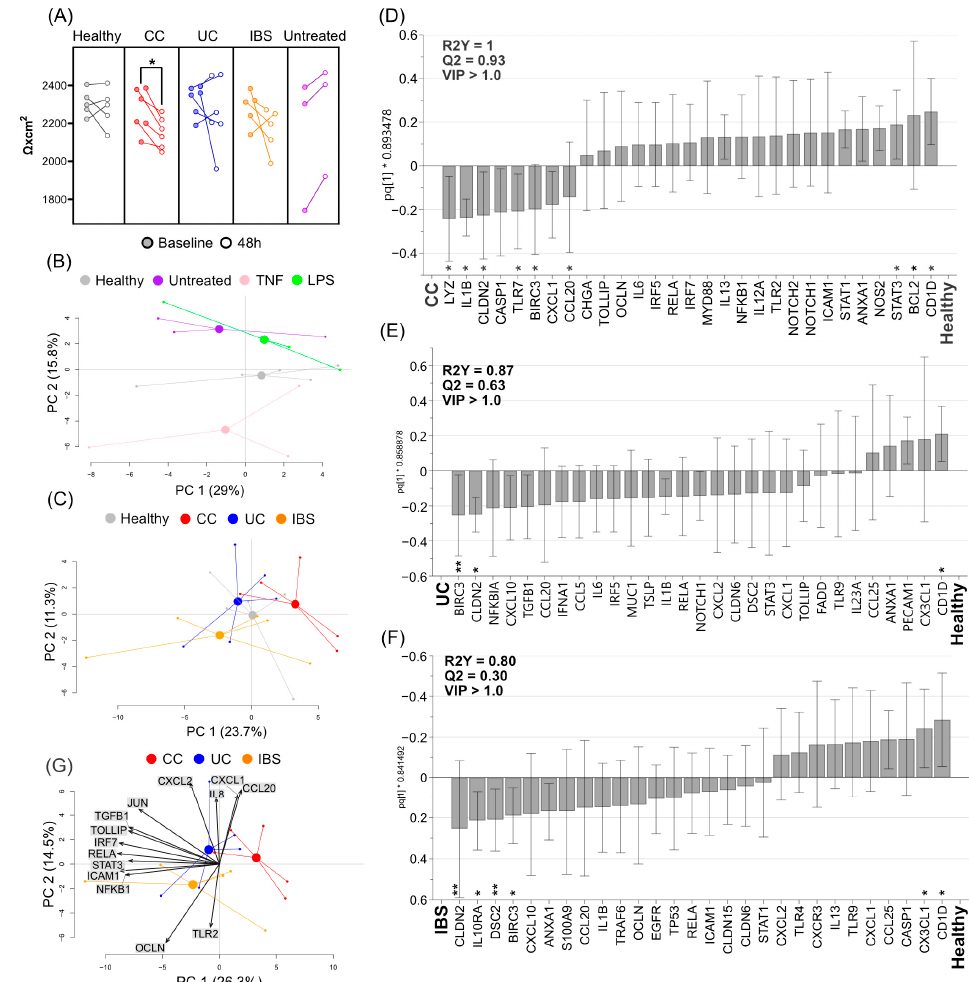
Figure 2. Gene expression of Caco-2 monolayers stimulated with fecal supernatants from healthy subjects and patients with colon cancer (CC), ulcerative colitis (UC) and irritable bowel syndrome (IBS). Caco-2 monolayers were differentiated for 20 days and stimulated apically with fecal super- natants and LPS or basolaterally with TNF or left untreated (cell culture medium alone), for 48 h. ( A ) Transepithelial electrical resistance was measured before (filled dots, each dot representing one sample) and after stimulation (corresponding unfilled dot), for healthy (grey), CC (red), UC (blue) and IBS (orange). Gene expression was analyzed by a custom PCR array. ( B ) Principal component analysis (PCA) for cells treated with fecal supernatants from healthy subjects (grey), LPS (green), TNF (pink) and media (purple). ( C ) PCA for cells treated with fecal supernatants from healthy subjects and CC (red), UC (blue) and IBS (orange) patients. Column loading plots from orthogonal partial least squares discriminant analyses (OPLS-DA) using a VIP cut-off > 1.0, comparing ( D ) healthy subjects and patients with CC, ( E ) healthy subjects and patients with UC and ( F ) healthy subjects and patients with IBS. ( G ) A PCA biplot for cells treated with fecal supernatants from patients with CC, UC and IBS. Between-group comparisons were tested with Mann–Whitney U test; asterisks identify statistically significant p values: * p < 0.05; ** p < 0.01. LPS ( n = 3), TNF ( n = 3), media ( n = 3); fecal supernatants ( n = 5 for each group). CC, colon cancer; UC, ulcerative colitis; IBS, irritable bowel syndrome; TNF, tumor necrosis factor; LPS, lipopolysaccharide; PC, principal